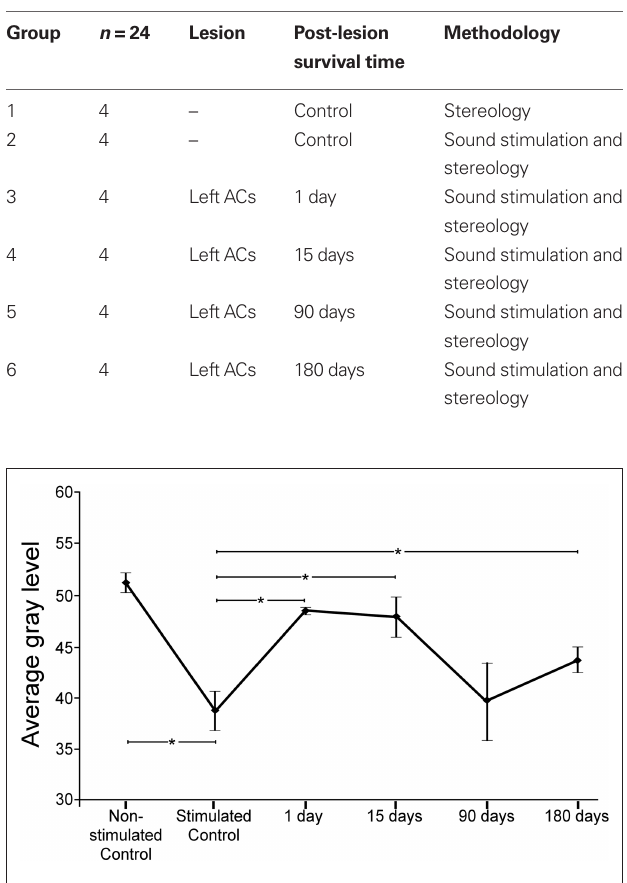
Table 1 | experimental groups.